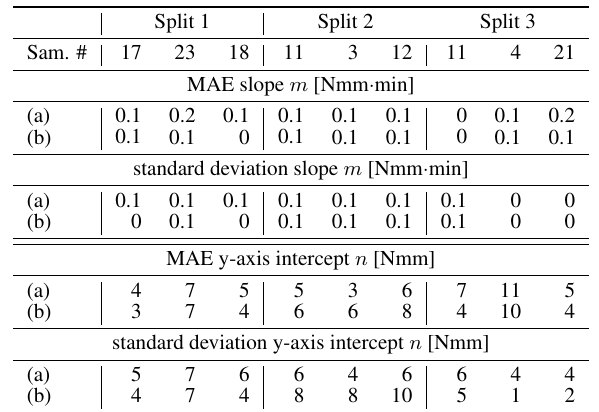
Table 3. Prediction of the regression parameters by (a) direct learning and (b) post-calculation from predicted support points.